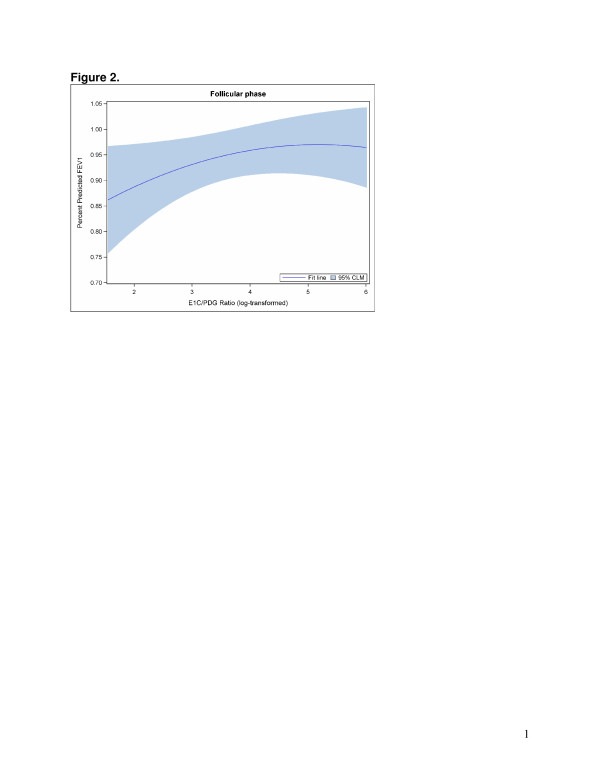
The log of PDG hormone level (x axis) associated with percent predicted FEV1 (y axis), adjusted for log of E1C in the follicular phase among all women. For purposes of illustrating the relationship between log PDG and FEV1, menstrual segment day is held constant at 7 days prior to ovulation and log E1C is set to its mean value.